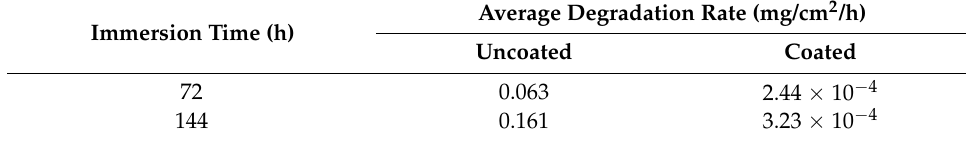
Table 5. Average degradation rate of naked and coated Mg6Zn alloys after 72 h and 144 h of immersion in 0.9% NaCl solution at 37 ◦ C